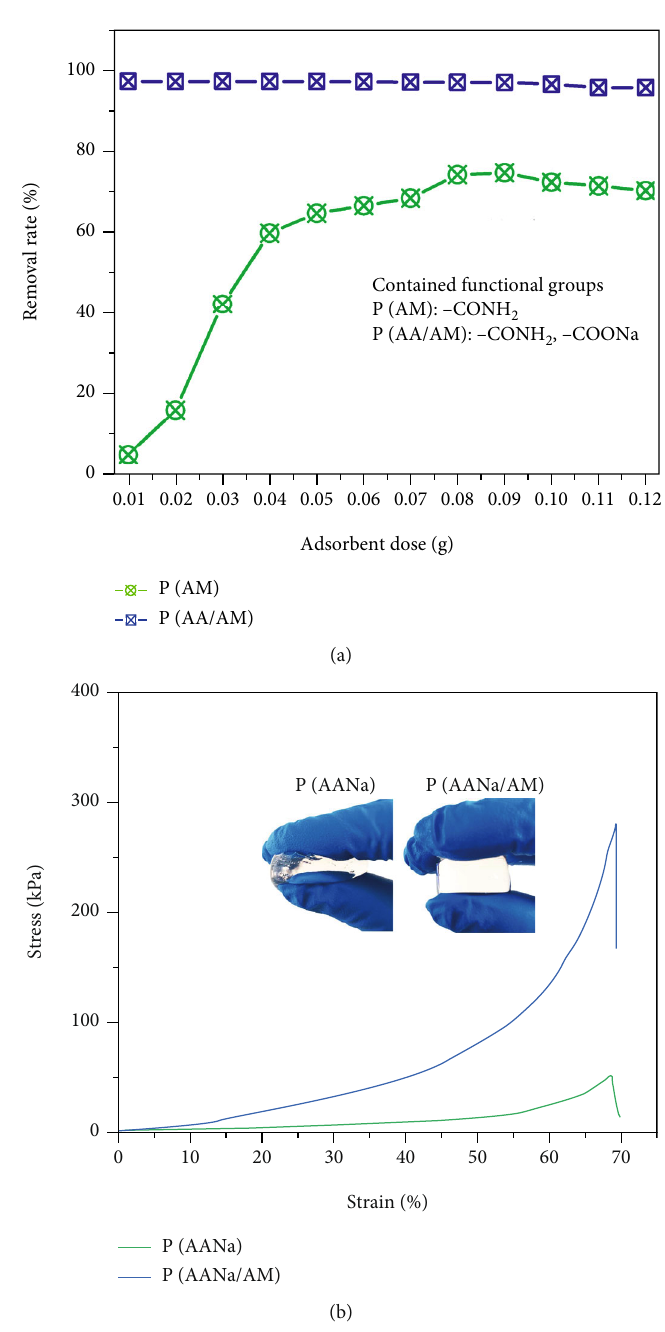
Figure 1: (a) E ff ect of adsorbent dose to MB removal rate. (b) Compressive strain-stress curves of P(AANa) and P(AANa/AM)